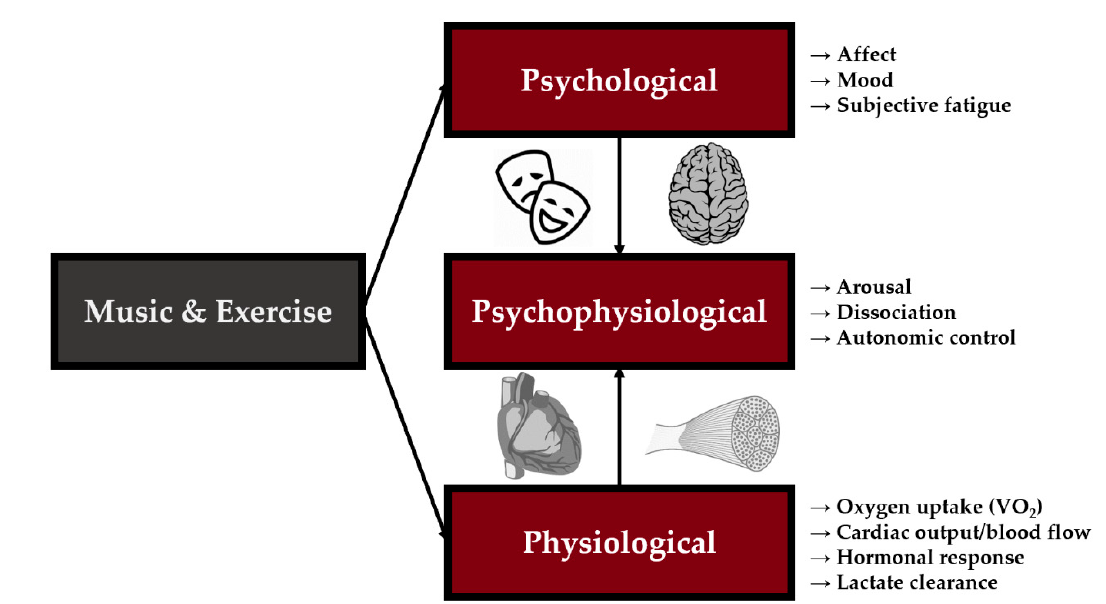
Figure 1. Three primary areas music has been suggested to have the largest impact on are: psychological, physiological, and psychophysiological. Selected variables by which music alters the experience response are shown although this is not an exhaustive list. Ultimately, psychological and physiological factors influence one another, creating an interrelated archetype for changes during exercise while listening to music.